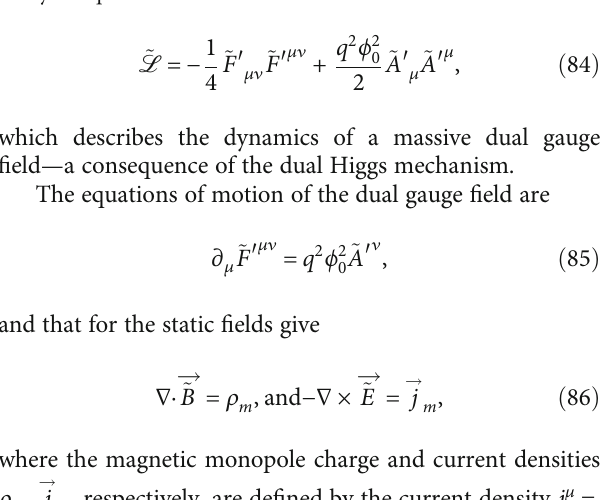
Figure 3: A graph of string tension σ heavy antiquark